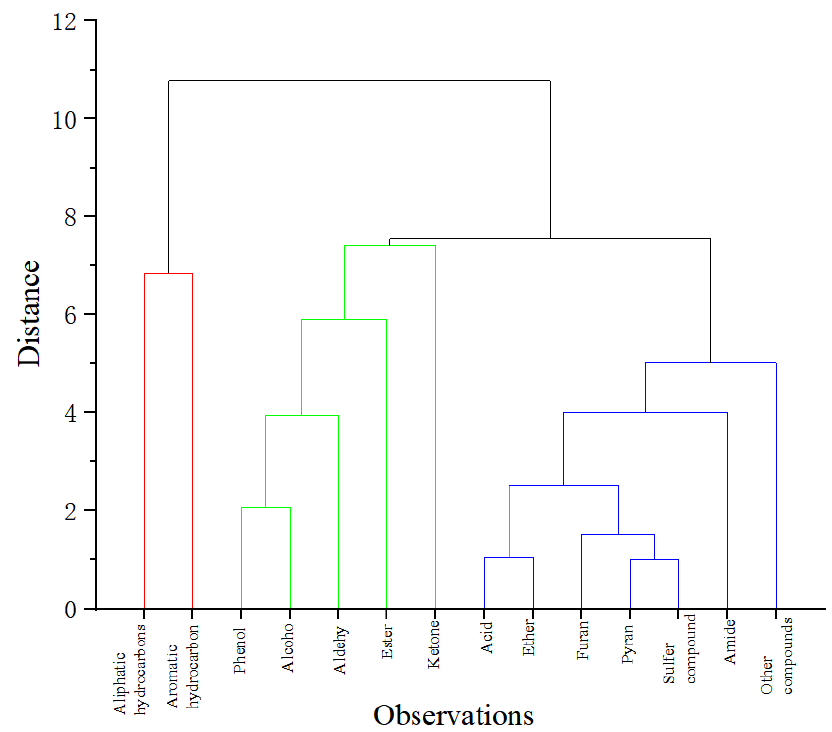
Figure 6. Cluster tree of 14 groups of extract family composition based on GC/MS data.